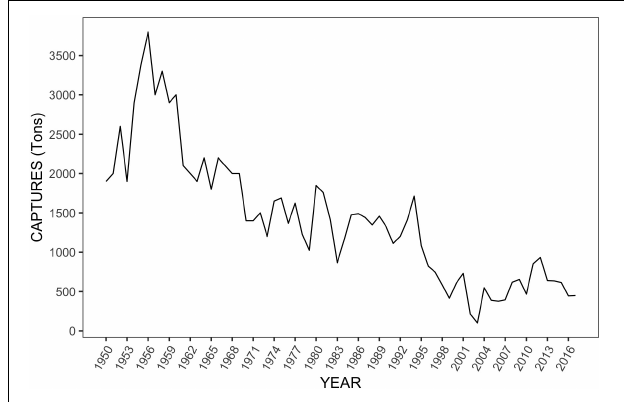
FIGURE 1 | Reported captures of red cusk-eel in Chile from 1950 to 2017. Data obtained from FAO data base using